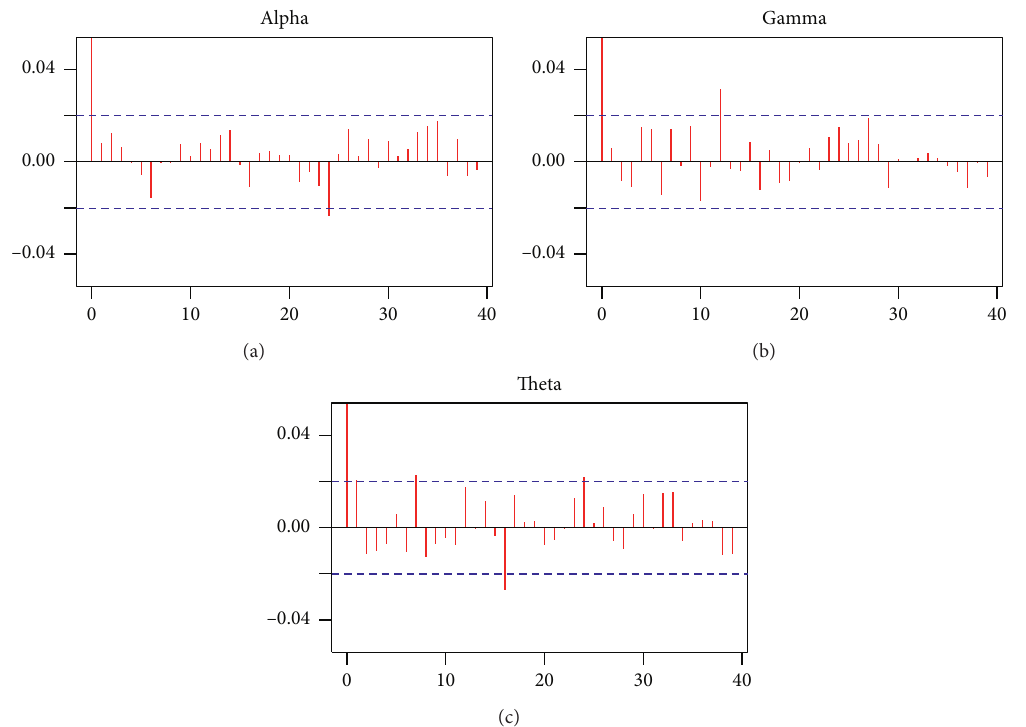
Figure 14: Autocorrelation plots of each parameter of NGE-Weibull